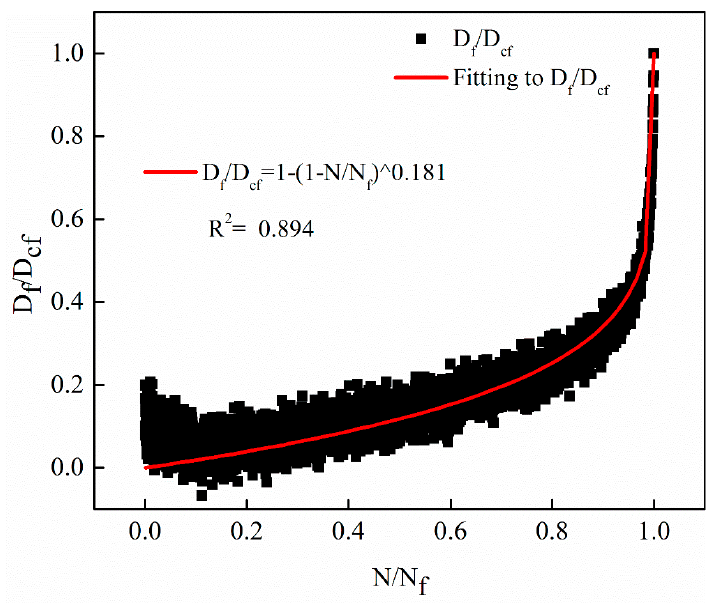
Figure 15. The evolution curves with stress levels of 0.5 MPa.